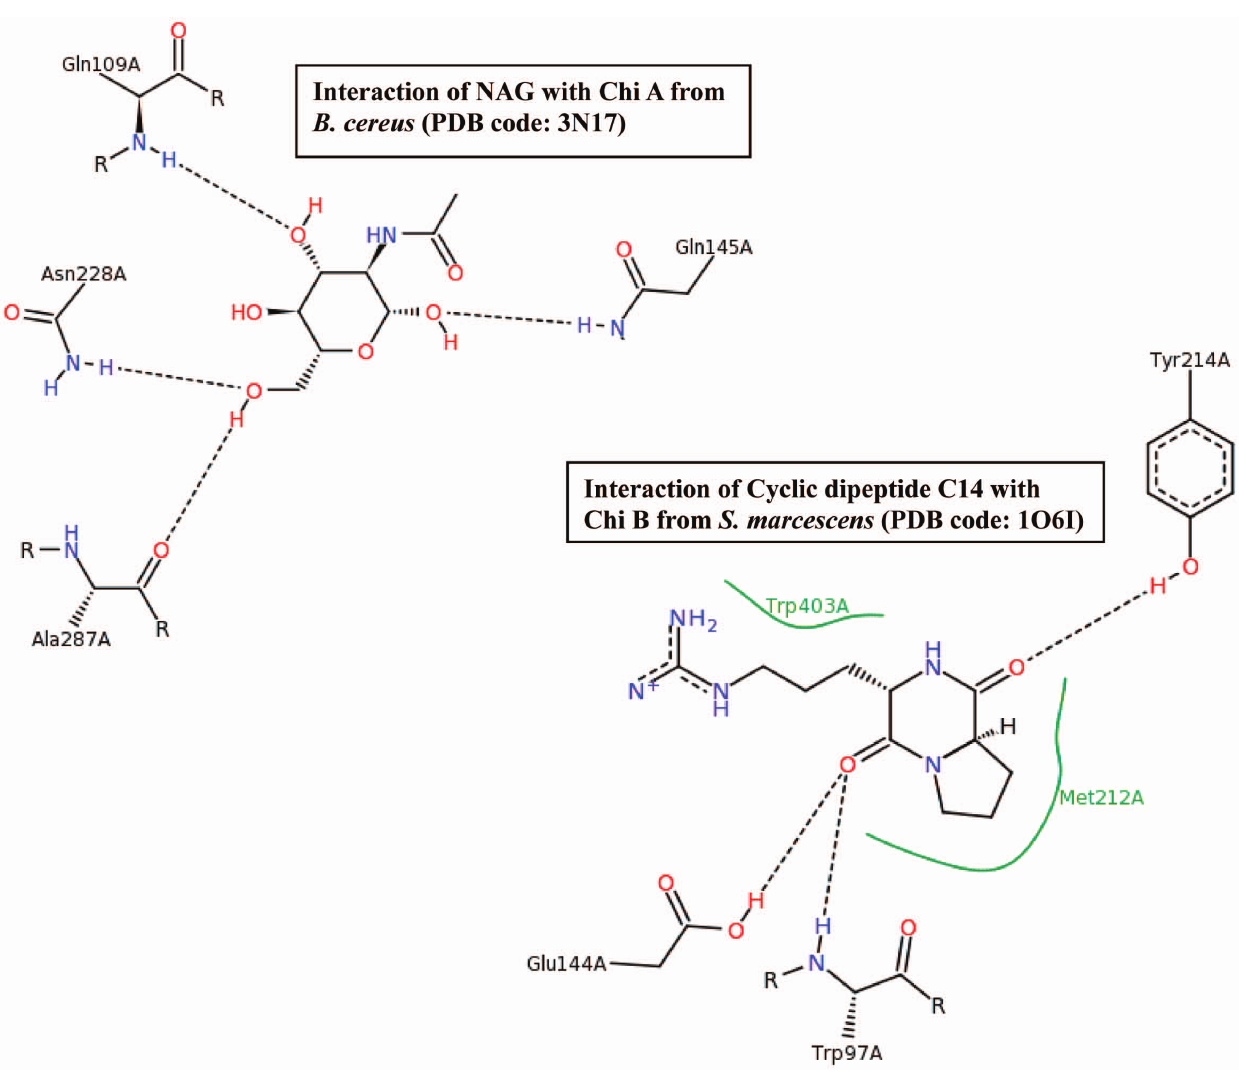
Figure 4. Ligand-protein interaction in 3N17 (NAG - Chi A) and 1O6I (Cyclic Dipeptide C14 - Chi B).